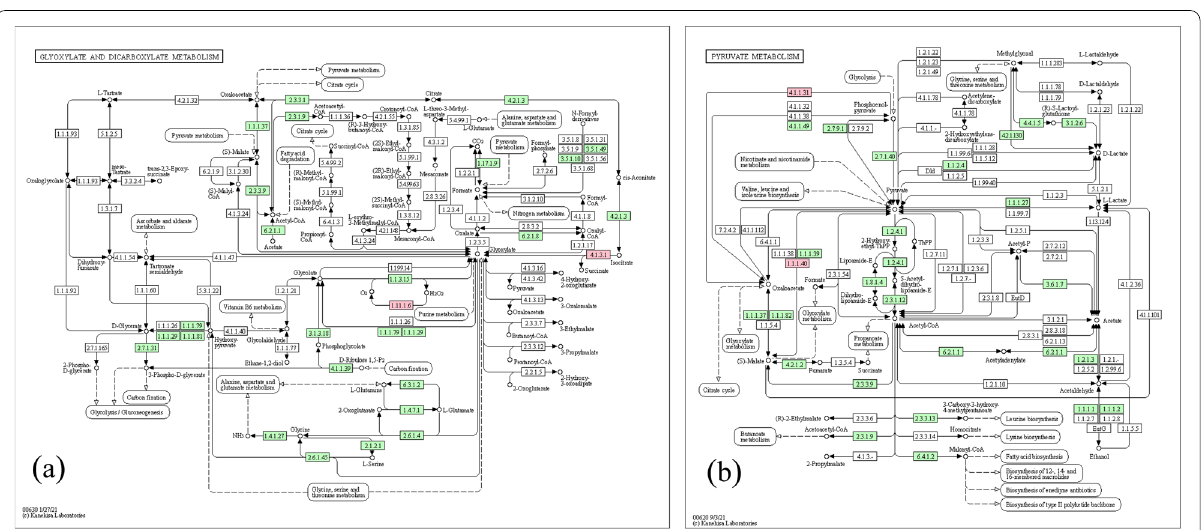
Fig. 6 KEGG pathway maps of glyoxylate and dicarboxylate metabolism and pyruvate metabolism . TaSAG7 and PEPC genes are active in these two pathways, which are important genes in drought